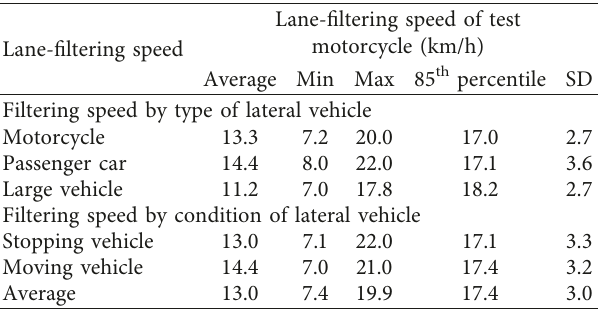
7: Measurement results of filtering speed of motorcycle riders.